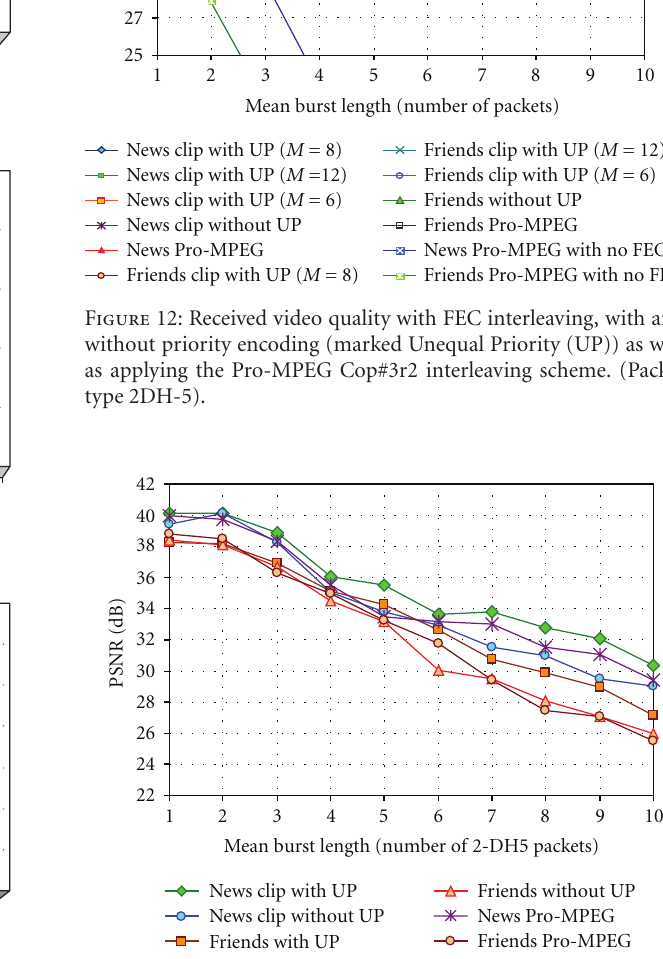
Figure 13: Received video quality with FEC interleaving, with and without priority encoding (marked Unequal Priority (UP)) as well as applying the Pro-MPEG Cop#3r2 interleaving scheme. (Packet type 3-DH5 but with burst lengths measured in 2-DH5 packets to allow comparison with Figure